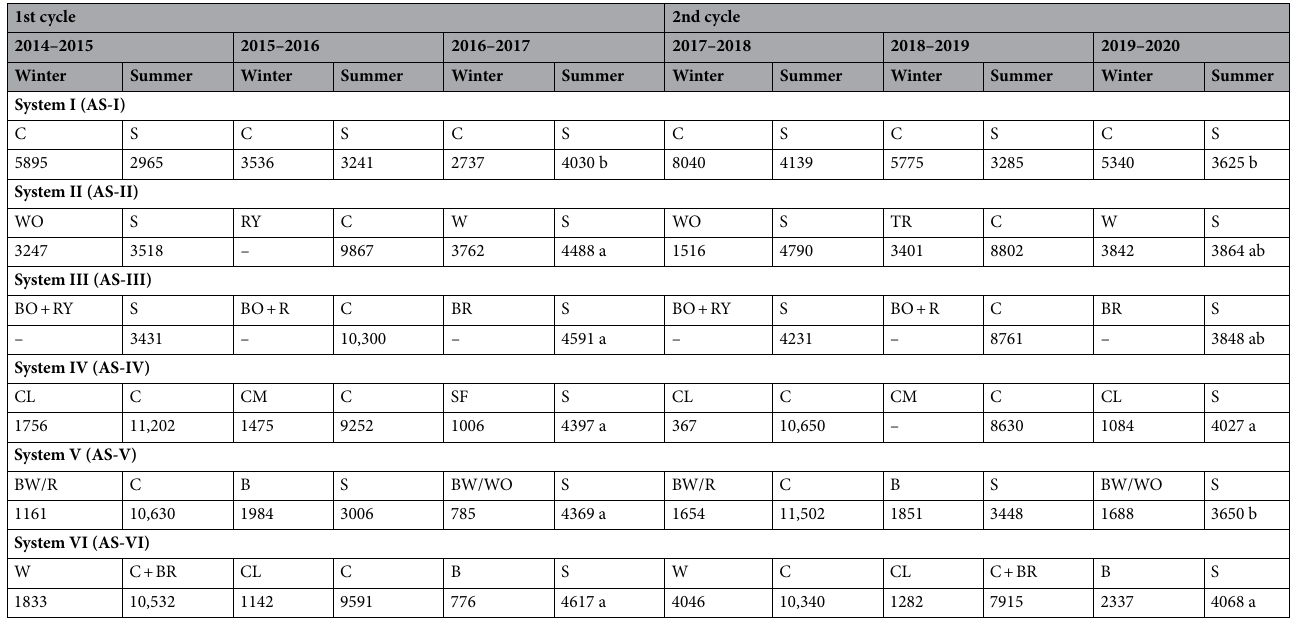
Table 2. Productivity (kg ha −1 ) of the crop rotation systems for the 2014–2015 to 2019–2020 crop years in Londrina, state of Paraná, Brazil. WO white oat, BO black oat, BR brachiaria, CL canola, CM crambe, RY rye, SF safflower, B bean, C corn, R forage radish, S soybean, W wheat, BW buckwheat, TR triticale. “– “: no